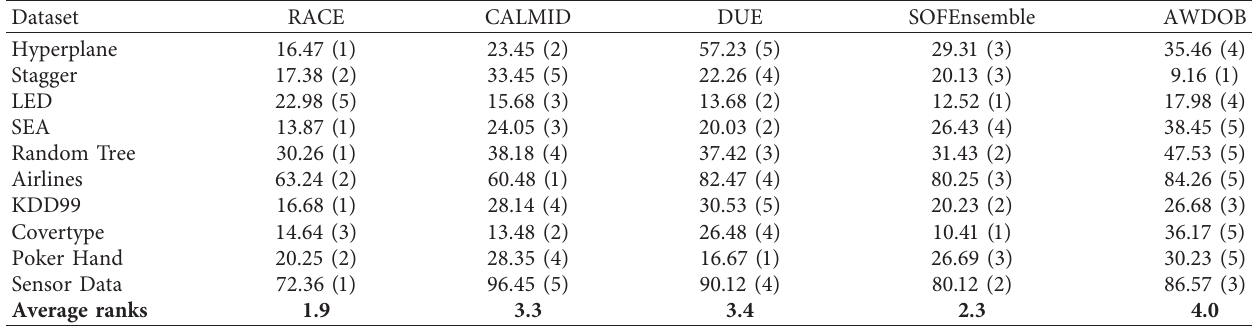
Table 8: CPU processing time of the algorithms using Hidden Markov Models.